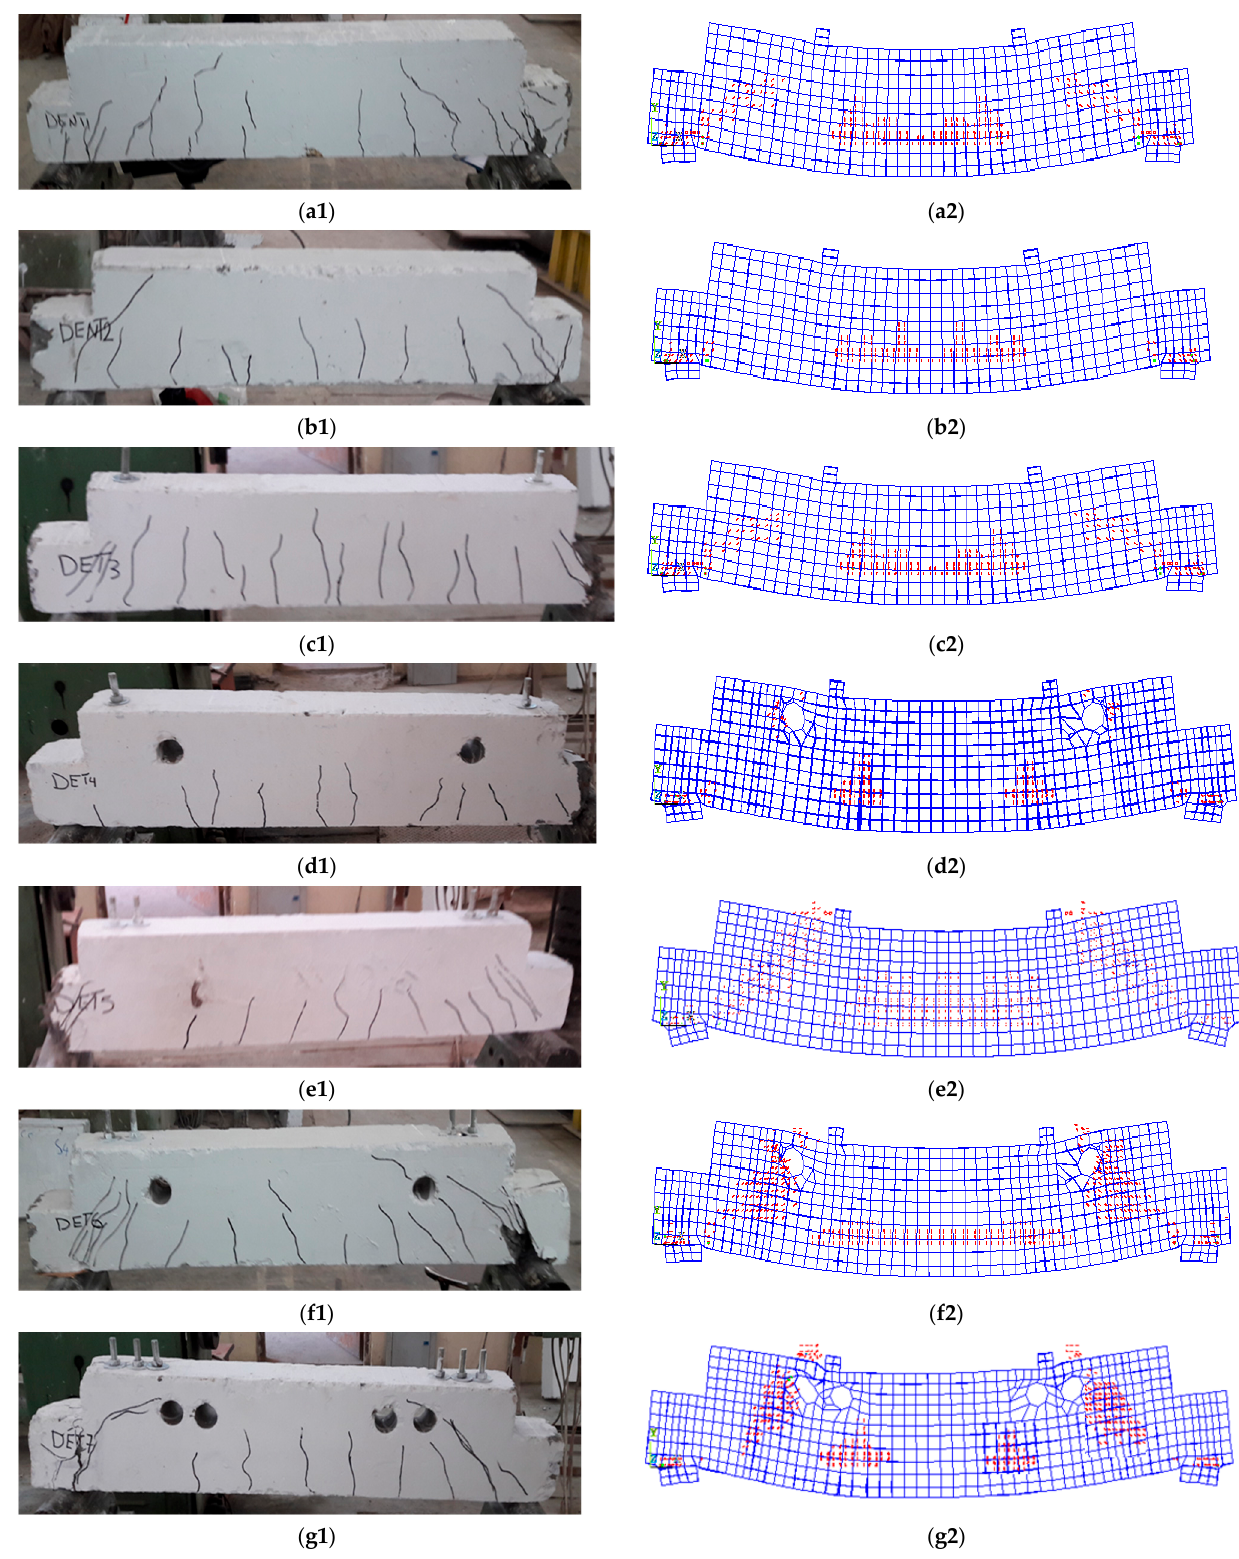
Figure 16. Comparison of the experimental/numerical crack patterns and failure modes of the RC girders with dapped ends. ( a1 ) DENT1 (Exp.). ( a2 ) DENT1 (Num.). ( b1 ) DENT2 (Exp.). ( b2 ) DENT2 (Num.). ( c1 ) DET3 (Exp.). ( c2 ) DET3 (Num.). ( d1 ) DET4 (Exp.). ( d2 ) DET4 (Num.). ( e1 ) DET5 (Exp.). ( e2 ) DET5 (Num.). ( f1 ) DET6 (Exp.). ( f2 ) DET6 (Num.). ( g1 ) DET7 (Exp.). ( g2 ) DET7 (Num.).